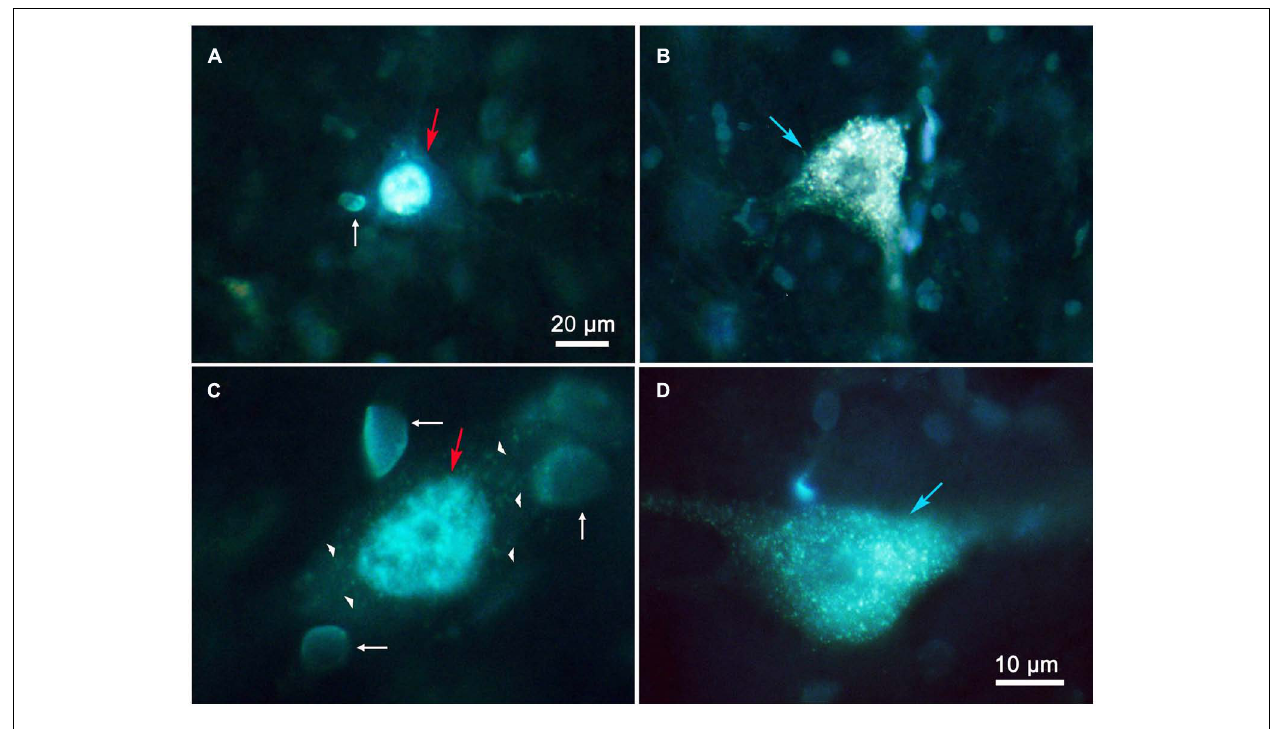
FIGURE 3 | Photomicrographs of labeled reticulotectal and pontine reticuloreticular neurons in MRF after combined injections of SC and PRF. (A,C) DY labeled reticuloreticular neurons. (B,D) FG labeled reticulotectal